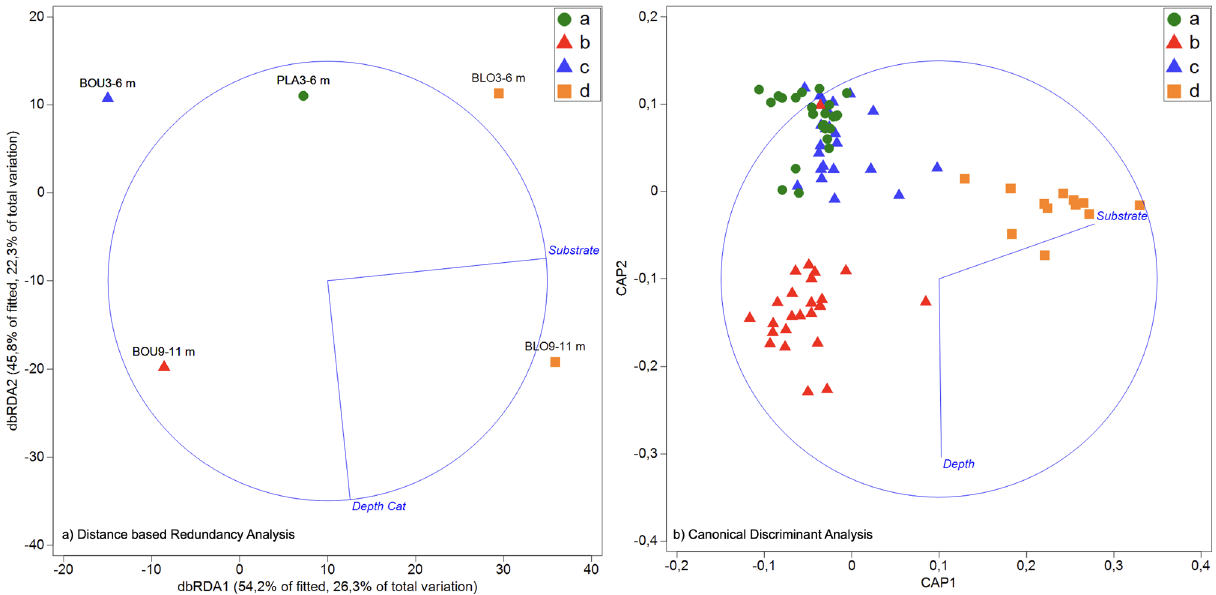
Figure 5. Predicting assemblages ( a – d ) through DistLM and correlations of Depth and Substrate (blue vectors overlay) with ordinations; ( a ) correlations with dbRDA axes most explaining total variation in samples, illustrating best solution from a Distance based Linear Model (left), and; ( b ) correlations with Canonical axes (CAP1 and CAP2) best discriminating sample-derived SIMPROF grouping of individual quadrats (right). Figure generated in PRIMER v7 (with PERMANOVA add-on).